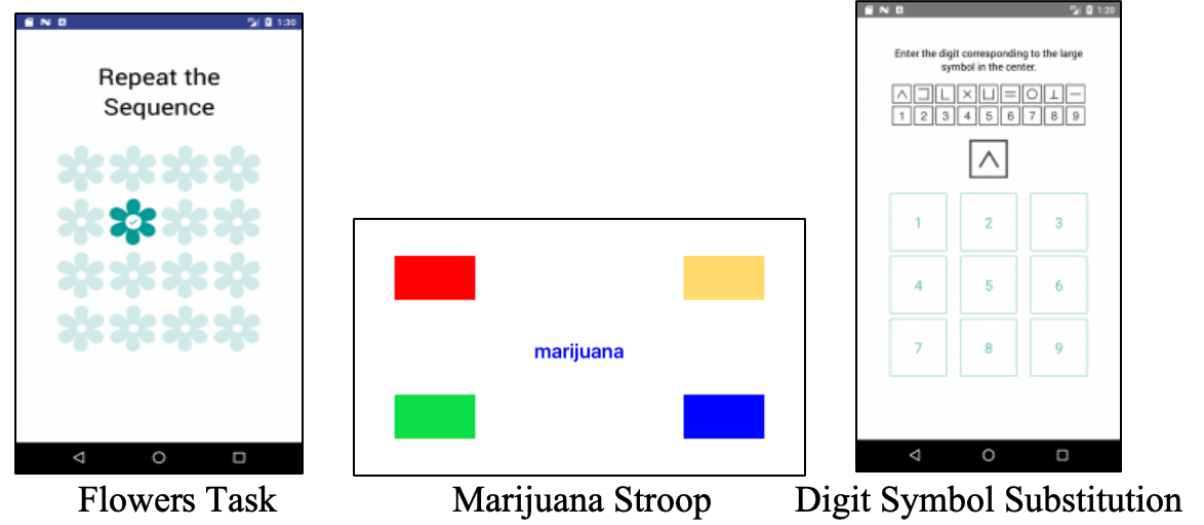
Figure 1. Screenshots of Flowers task, marijuana Stroop, and digit symbol substitution